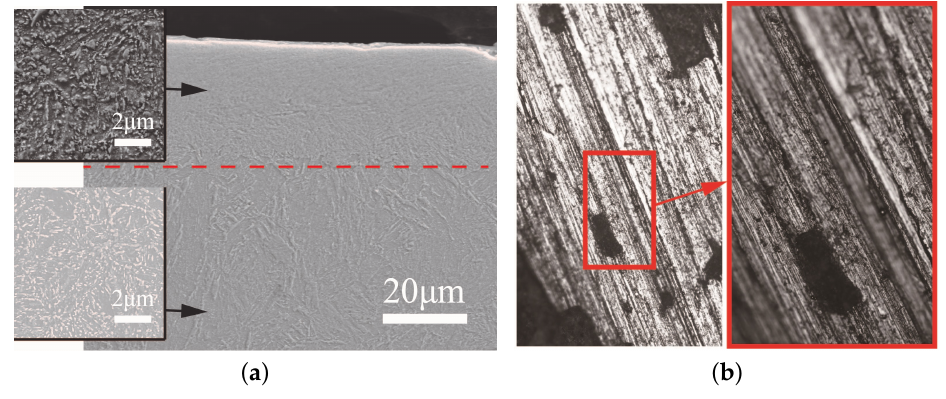
Figure 3. The surface microstructure of the residual projectile. ( a ) Microstructure of longitudinal section of residual projectile nose. There are two distinct zones: the microstructure inside the projectile almost unaffected by friction heat, while the microstructure near the surface of the projectile becomes denser. ( b ) Microscopic observation of the surface of the projectile nose by metallographic microscope. Many parallel and long grooves distributed on surface of the projectile